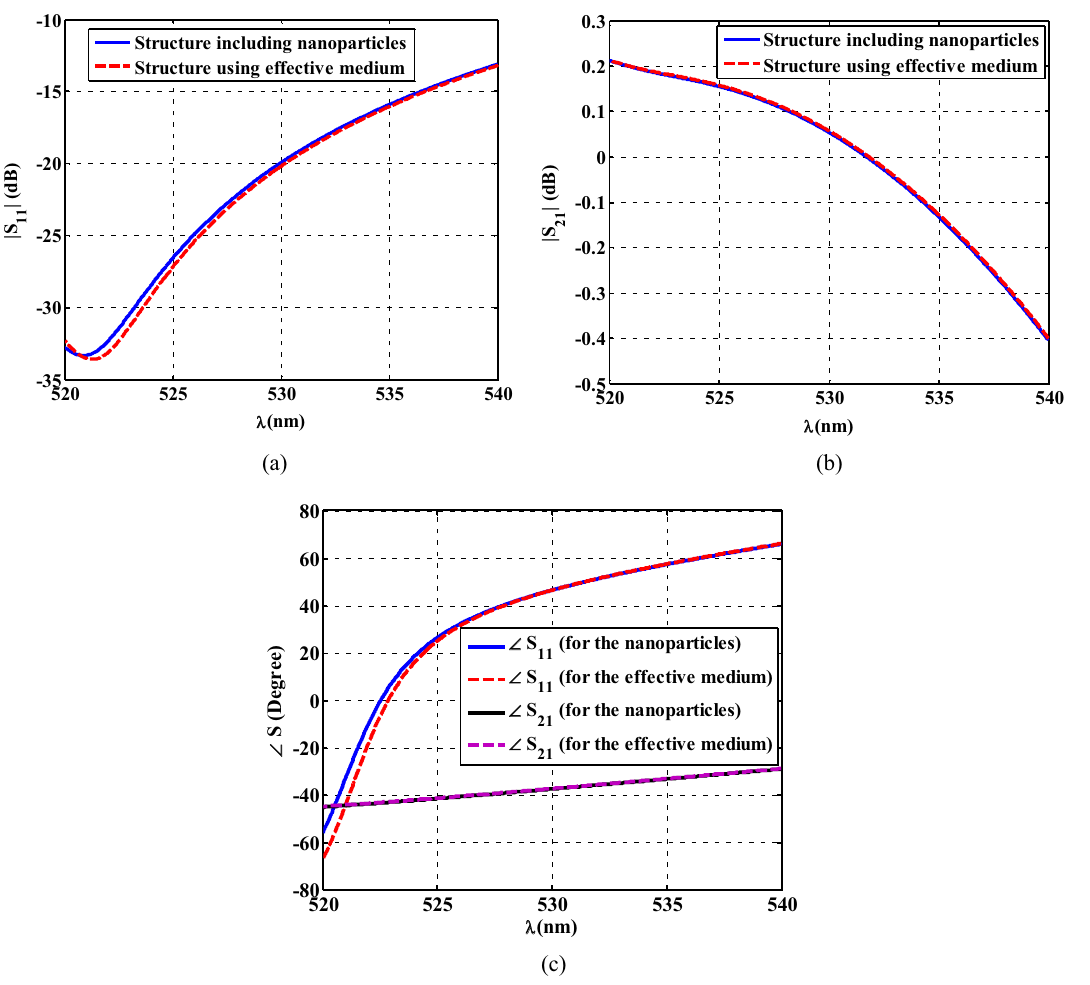
Figure 8. Simulation results of a slab containing real nanoparticles is compared with a slab with effective parameters. ( a ) Magnitude of S 11 , ( b ) magnitude of S 21 , ( c ) phase of S 11 and S 21